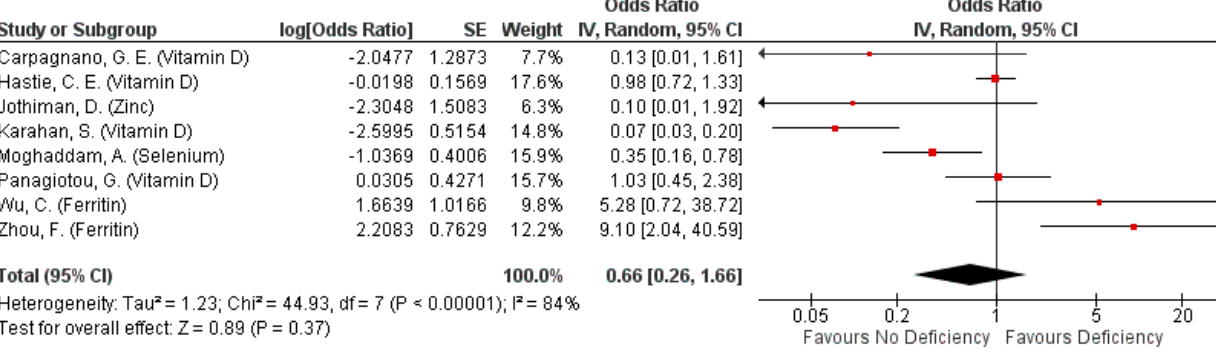
Figure 4. Pooled odds ratio on ICU admission due to COVID-19 episode when hospitalized subjects are not deficient, compared to those deficient in any micronutrient singly.